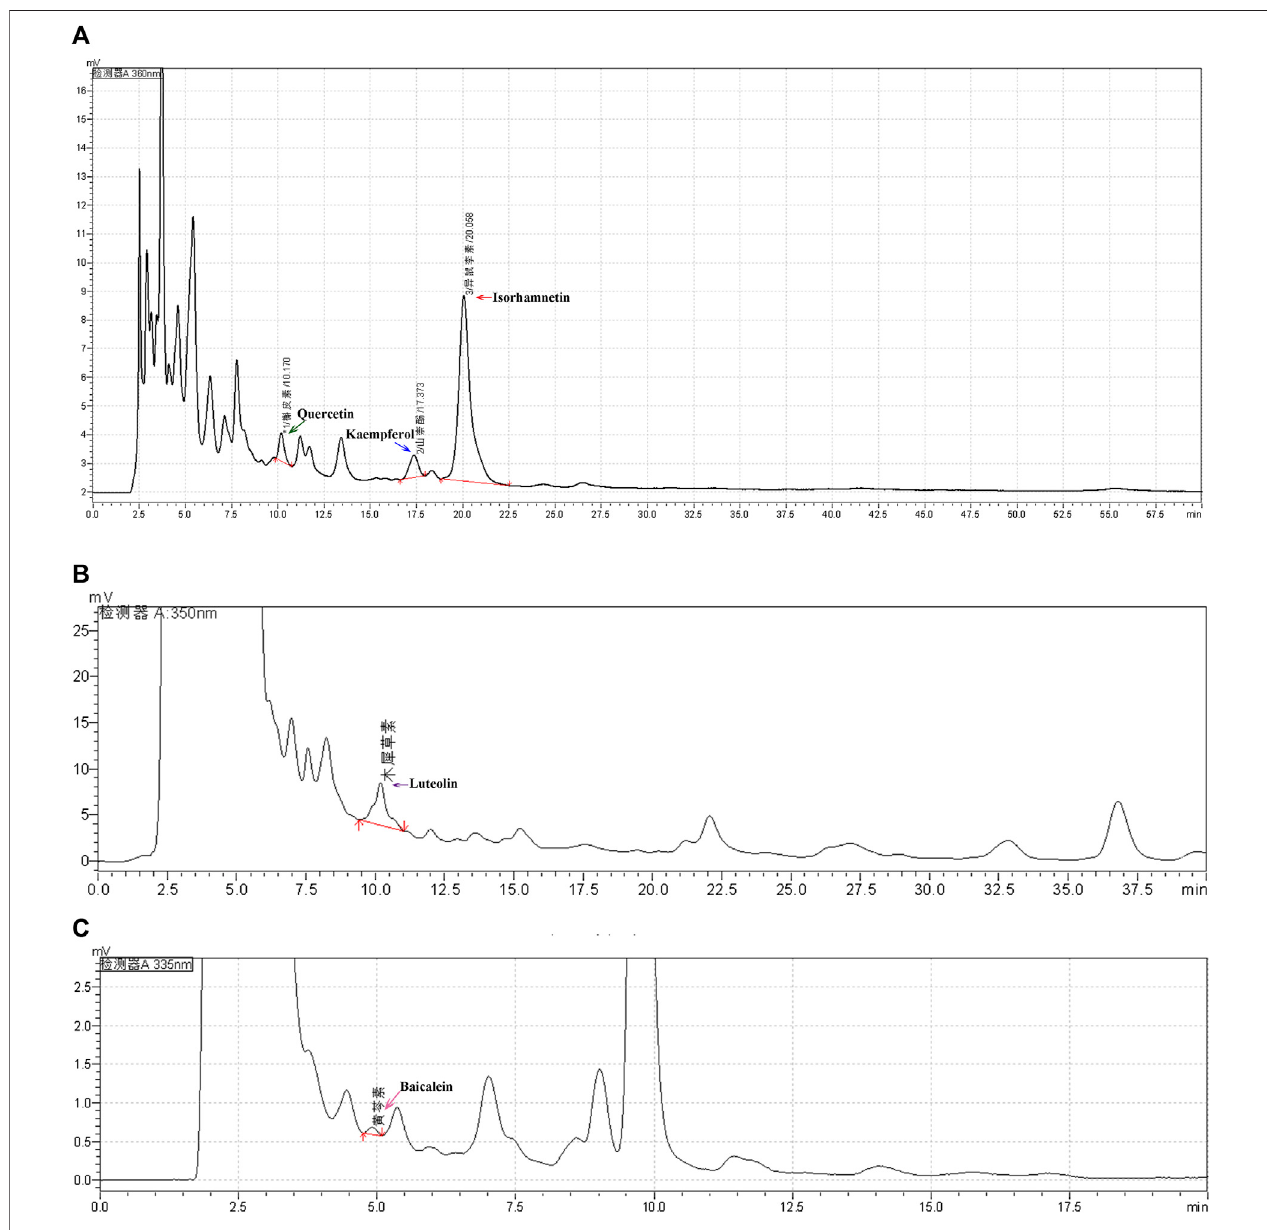
FIGURE 4 | The HPLC chromatogram of XFZYD. HPLC analysis of fi ve chemical constituents, quercetin ( a , 360 nm), kaempferol [ (A) , 360 nm], isorhamnetin [ (A) , 360 nm], luteolin [ (B) , 350 nm), and baicalein [ (C) , 335 nm], in XFZYD. The tested peaks are indicated by green, blue, red, purple, and pink arrows.